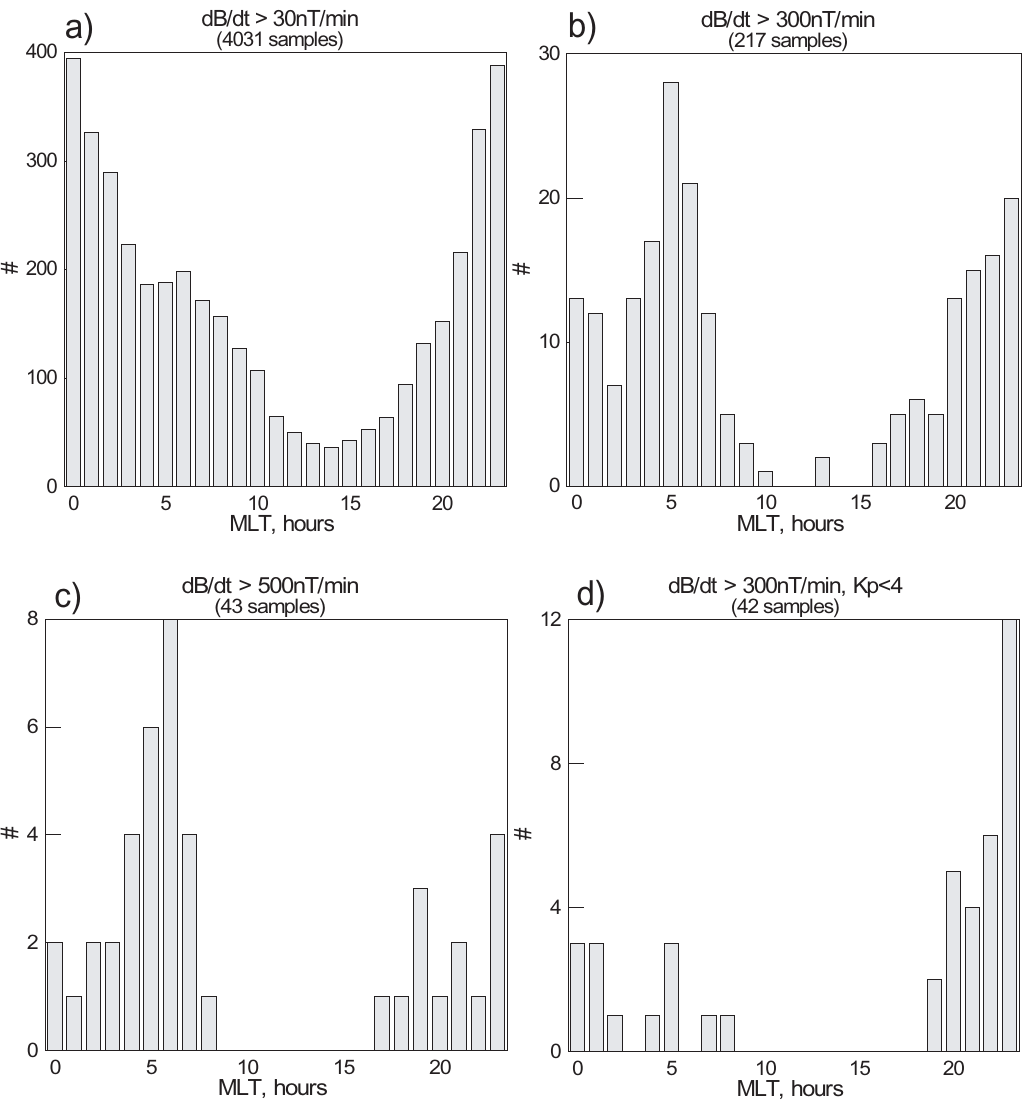
Fig. 6. MLT occurrence of hours which have at least one sample with dB/dt above the given threshold. The thresholds are (a) − 30nT/min, (b) -300nT/min, (c) − 500nT/min. (d) – the same threshold as in (b), but only small K p samples are